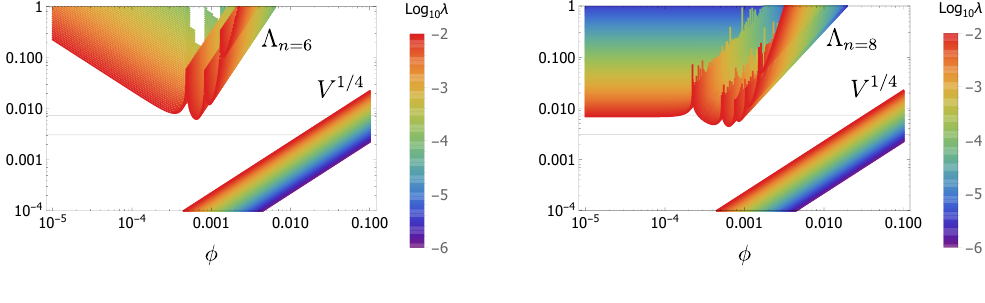
p (cid:14) (right plot).